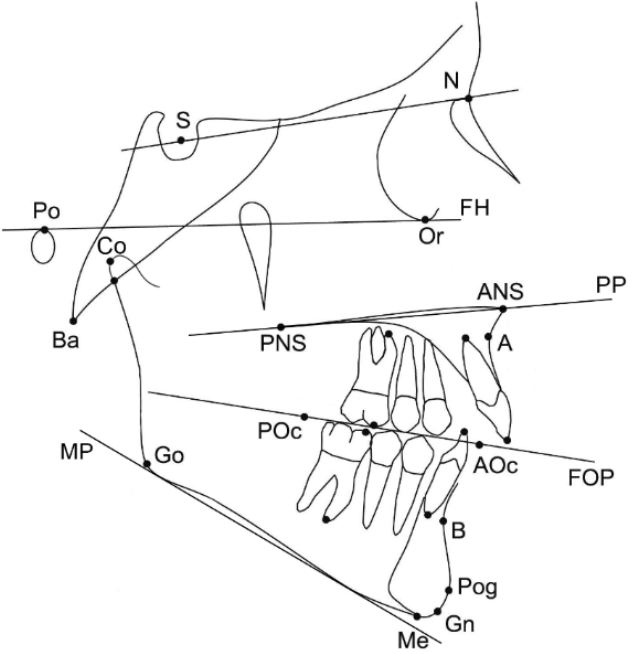
Figure 2. Landmarks and reference planes that were used for the study. Skeletal landmarks: sella (S), nasion (N), porion (Po), orbitale (Or), anterior nasal spine (ANS); posterior nasal spine (PNS); A-point (A), B-point (B), pogonion (Pog), gnathion (Gn), menton (Me), gonion (Go), condylion (Co), basion (Ba). Dental landmarks: maxillary and mandibular first molar mesial cusp, maxillary and mandibular first molar mesial apex, maxillary and mandibular incisor tip, maxillary and mandibular incisor apex, posterior occlusal point (POc), anterior occlusal point (AOc) (occlusal points were placed arbitrarily along the functional occlusal plane based on the occlusal contacts of the premolars and molars). Reference planes: Frankfurt horizontal plane (FH), palatal plane (PP), functional occlusal plane (FOP), mandibular plane (MP) (line tangent to the lower part of the mandible).